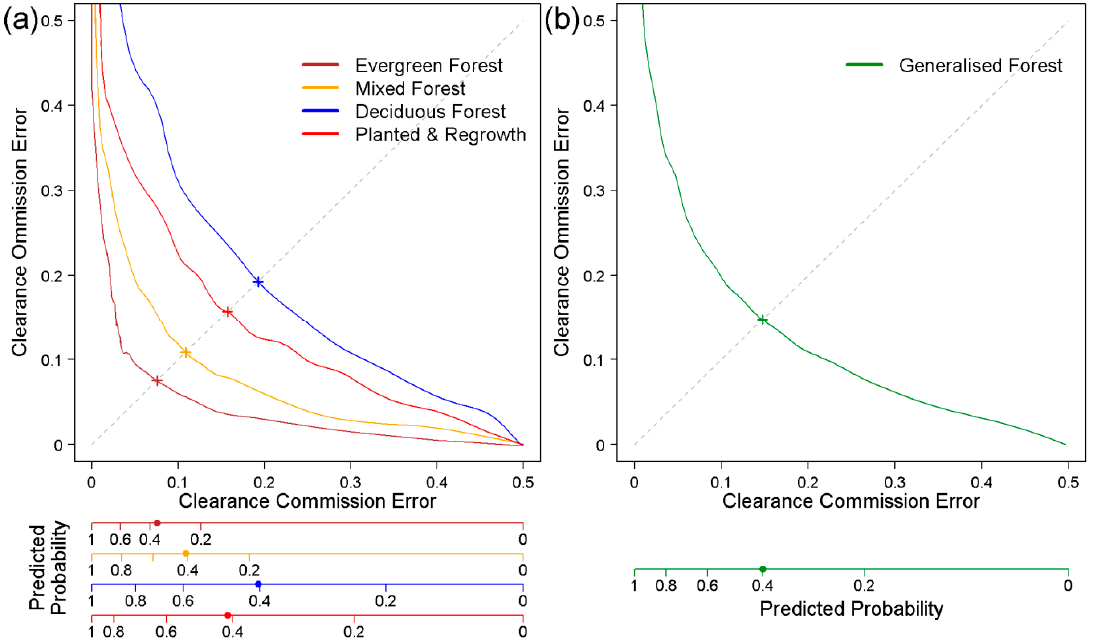
Figure 5. Forest clearance commission Vs omission errors for: the forest-type specific models ( a ); and the generalised forest model ( b ). All models presented used the bmag + slp variable combination. Points where errors are balanced follow the 1:1 dashed line. Predicted probabilities for each model are shown as additional x-axes using the same colour scheme. Points marked on the predicted probability axes are at thresholds where errors area balanced.